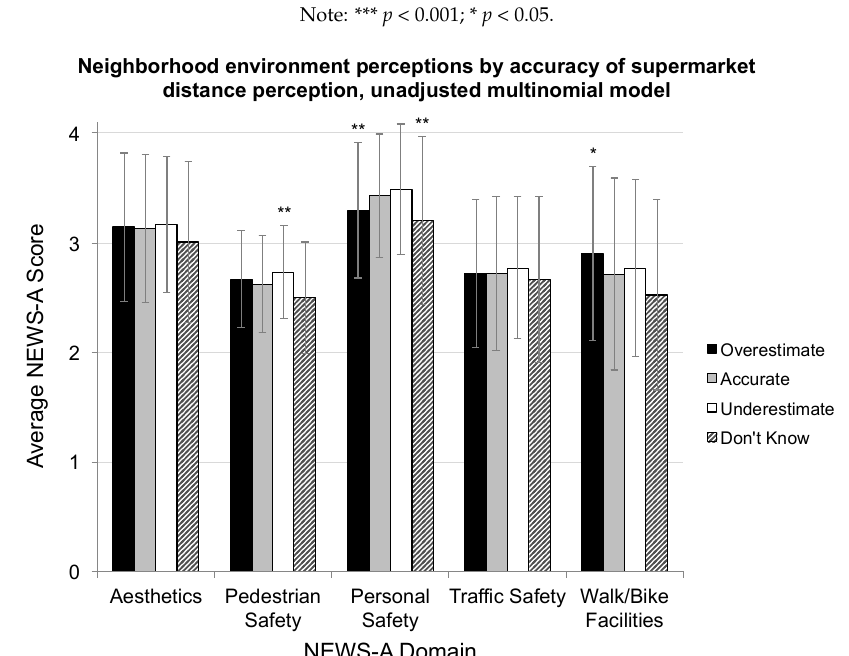
Figure 3. Average accurate, over-, and underestimator perceptions of neighborhood environment measured with the abbreviated NEWS (NEWS-A) instrument. Note: ** p < 0.01; * p < 0.05 for z-test of coefficients for distance perception categories compared to accurate in unadjusted multinomial log-linear model.